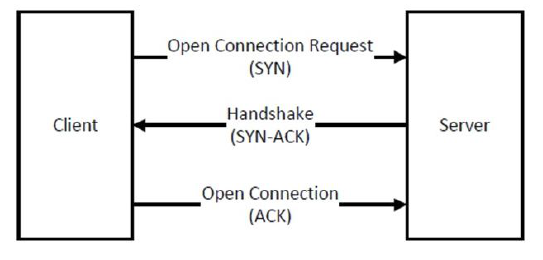
Figure 2. Communication fundamentals using TCP/IP protocol.